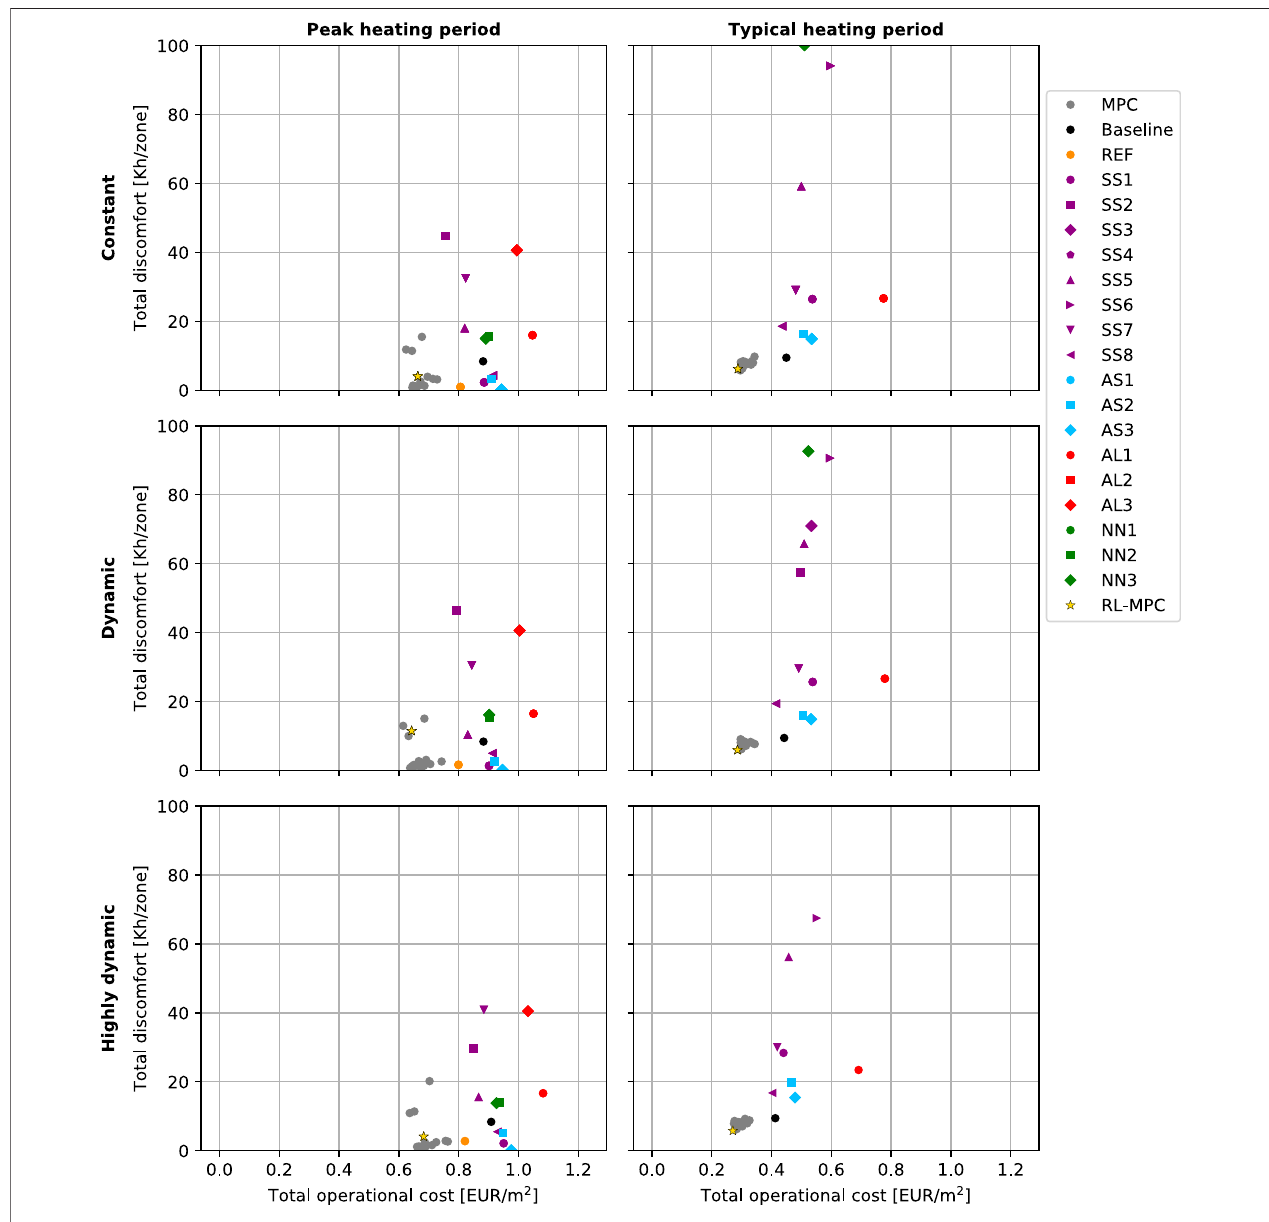
FIGURE 10 | RL performance results for different test case runs in each of the BOPTEST scenarios. The rows show the results for the same pricing scenario, and the columns for the same period scenario. The results are obtained for different con fi gurations of the state space, action space, learning algorithm, and neural network